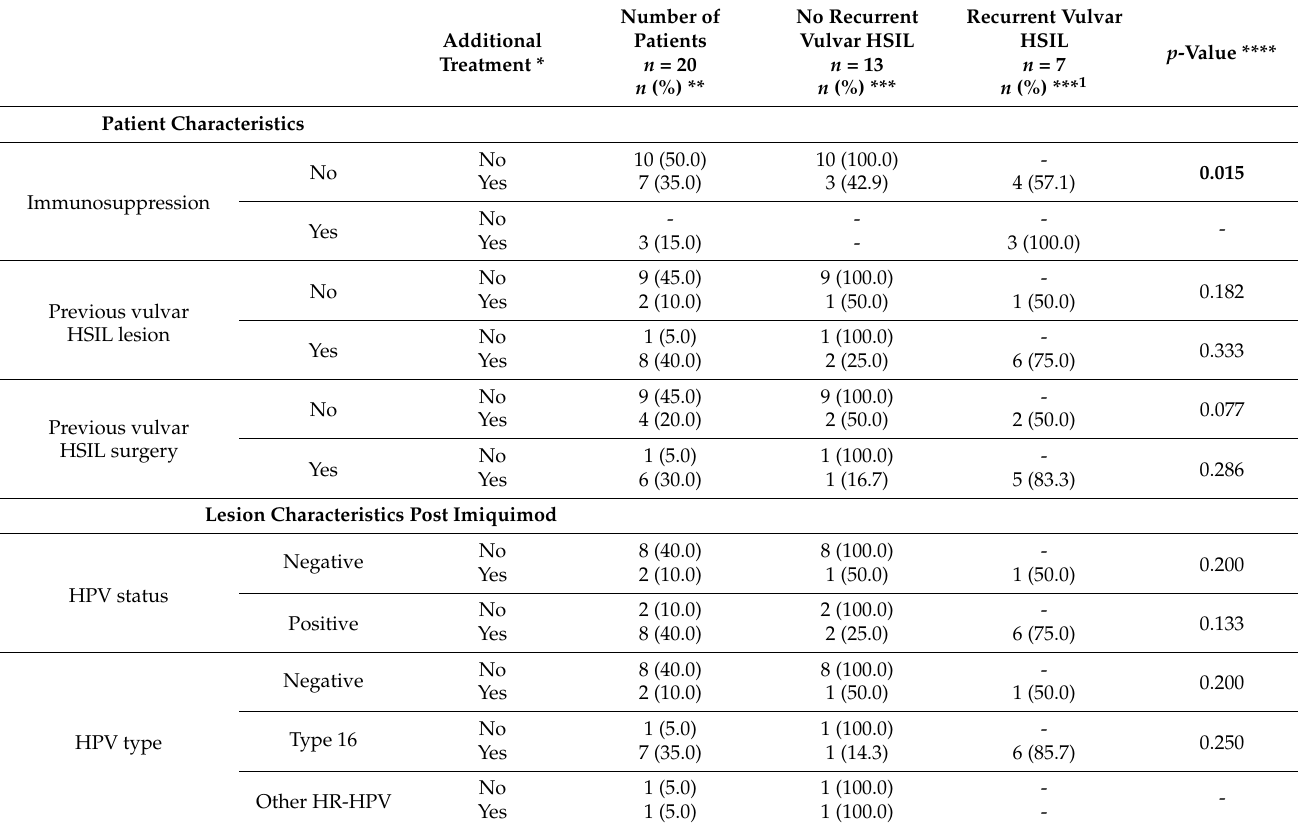
Table 6. Recurrent vulvar HSIL in cases with and without additional treatment after treatment with